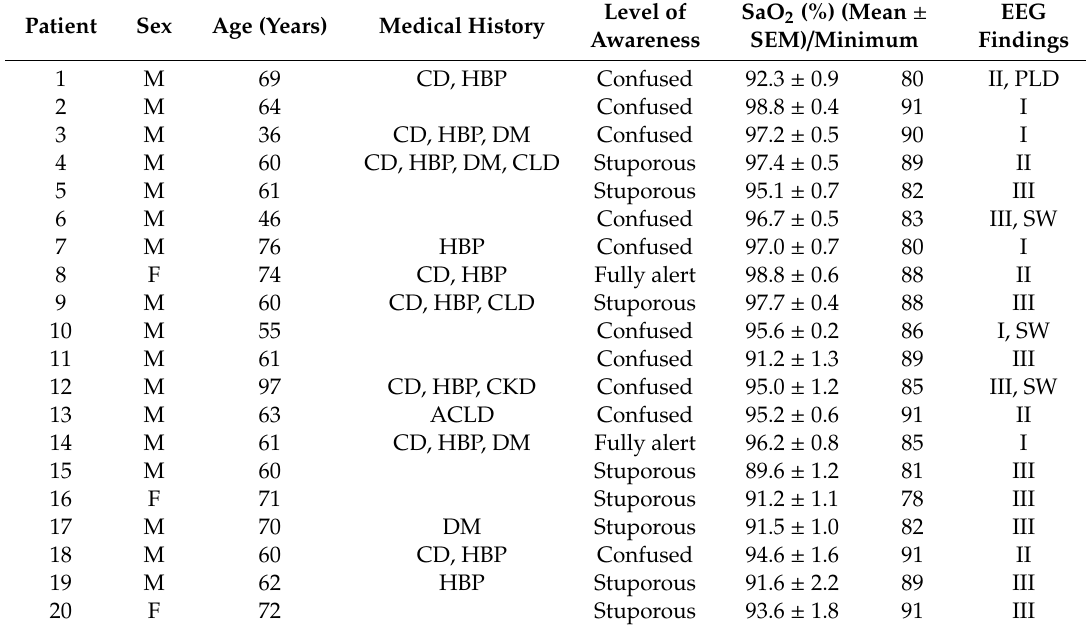
Table A2. Patients with SARS-CoV-2 (COVID).